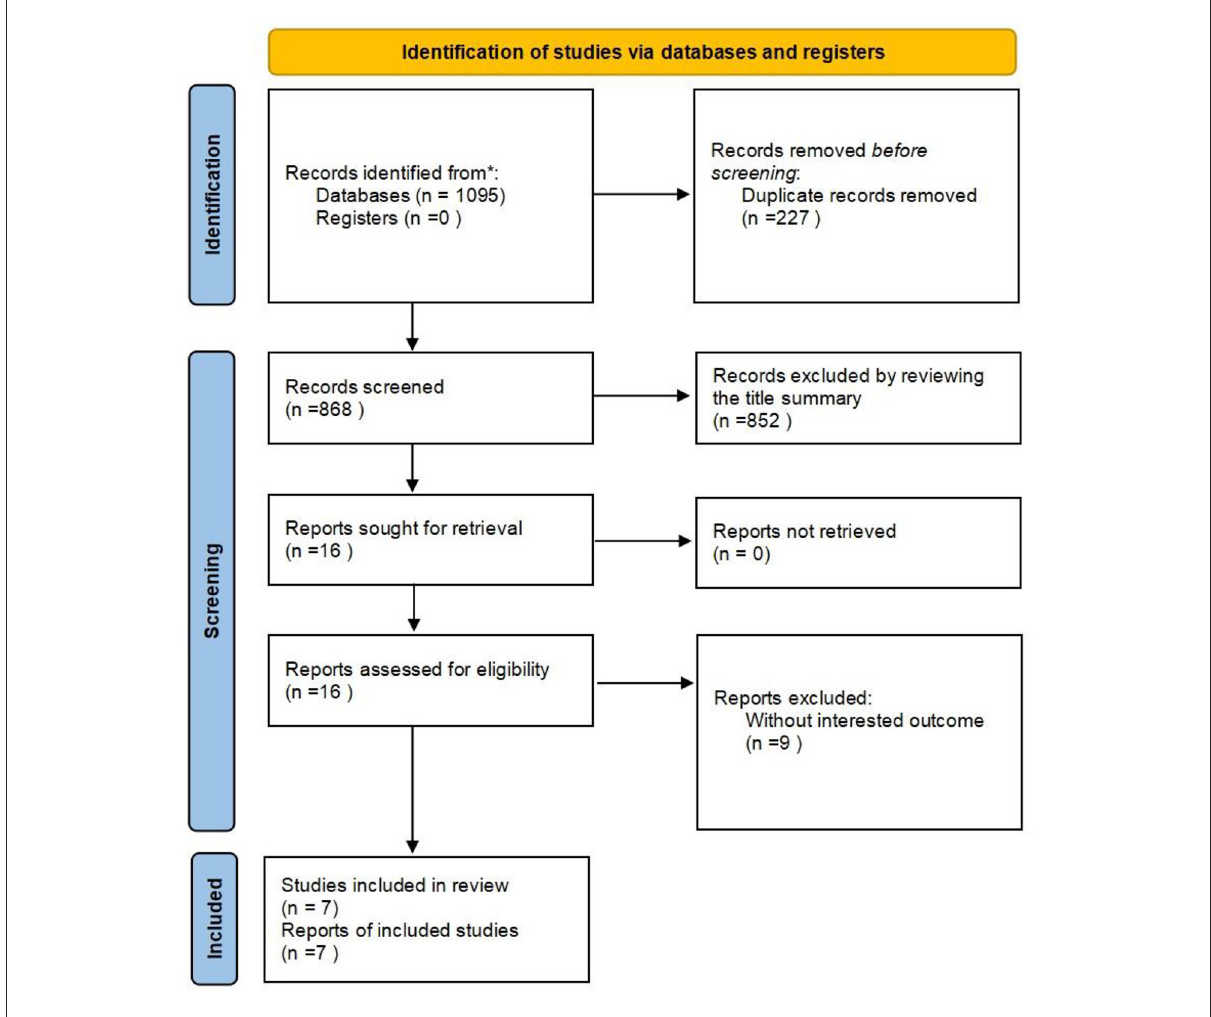
FIGURE1 Studies screening